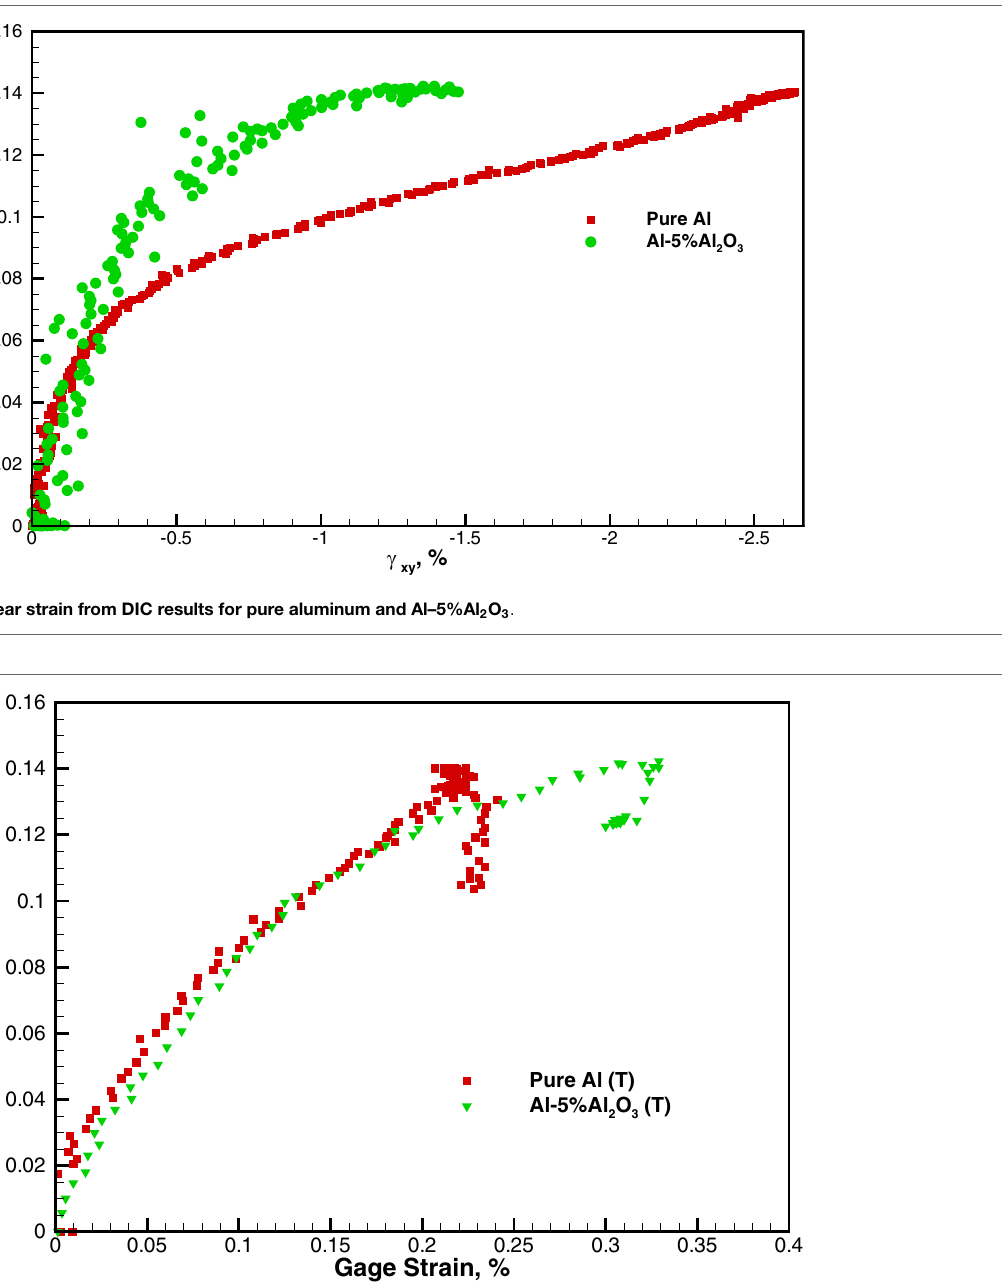
FIGURE 7 | Stress versus transverse strain from DIC results for pure aluminum and Al–5%Al 2 O 3 .